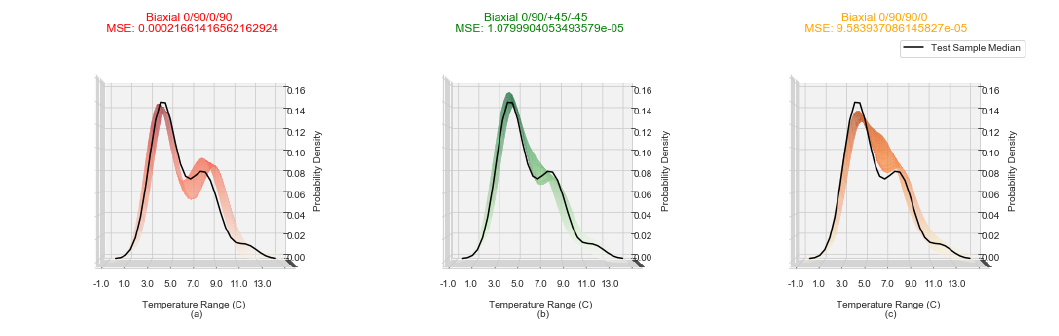
Figure 5. A Biaxial 0/90/+45/ − 45 sample compared against the KDE / t for ( a ) Biaxial 0/90/0/90, ( b ) Biaxial 0/90/+45/ − 45, ( c ) Biaxial 0/90/90/0.